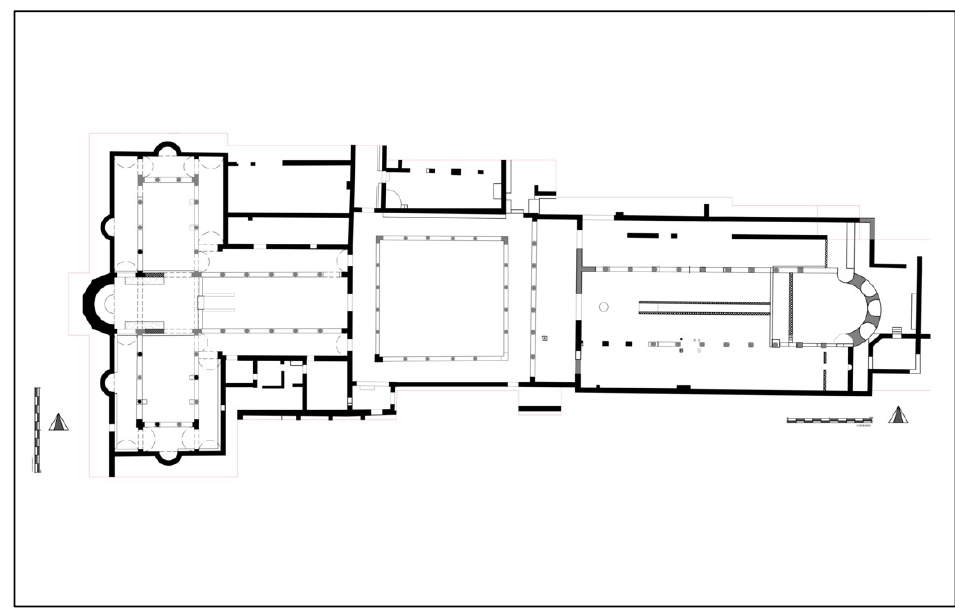
Figure 5. Katalymmata ton Plakoton basilicas (Procopiou 2018, p.